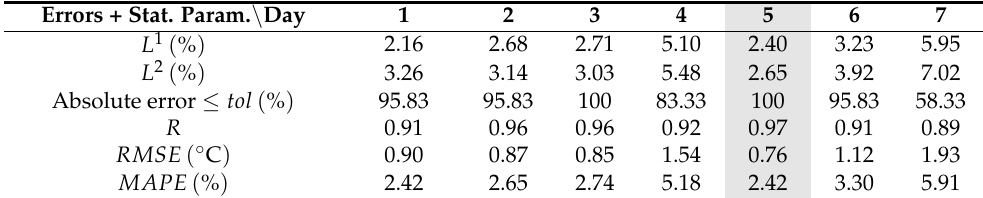
Table 13. Relative Error CS17. Errors + Stat. Param. \